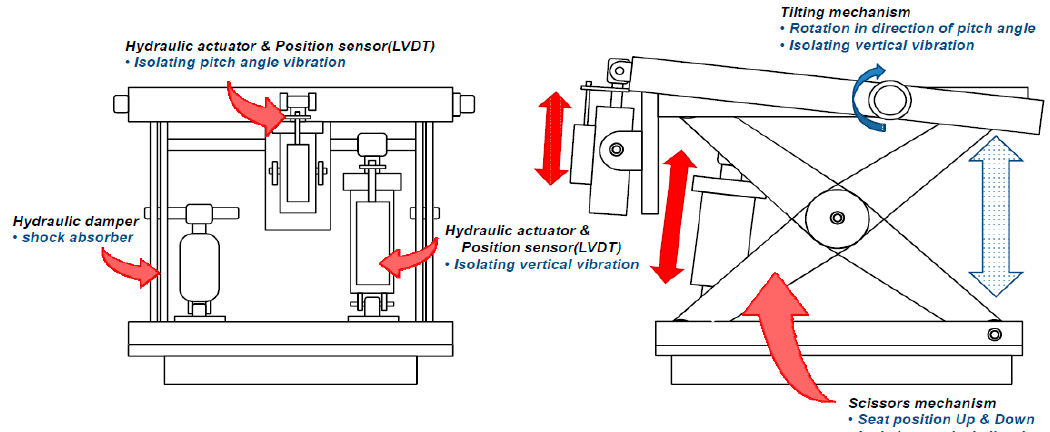
Figure 12. Active seating suspension system scheme [51].